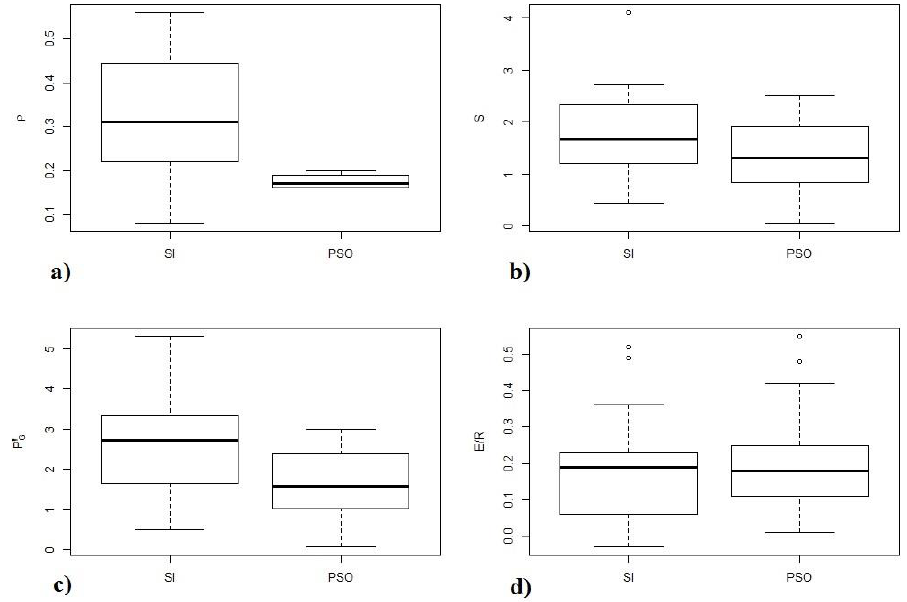
Figure 10. Box plot of Gash model parameters with IS and particle swarm optimization (PSO) parameterization methods: ( a ) ρ ; ( b ) S; ( c ) PG’; and ( d ) E/R.